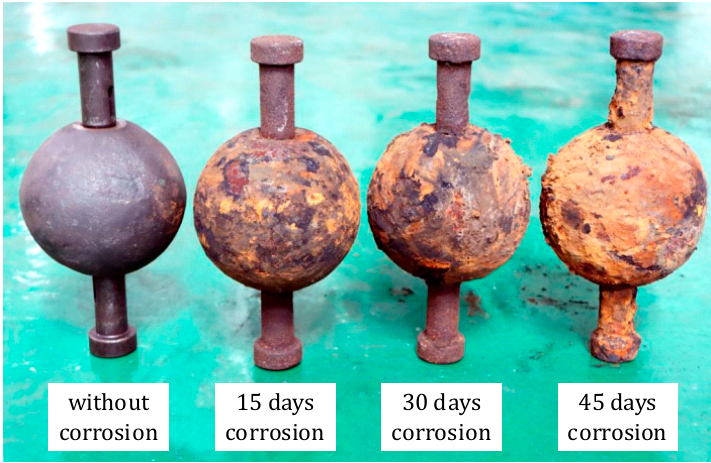
Figure 5. Corroded bolt-sphere connections.